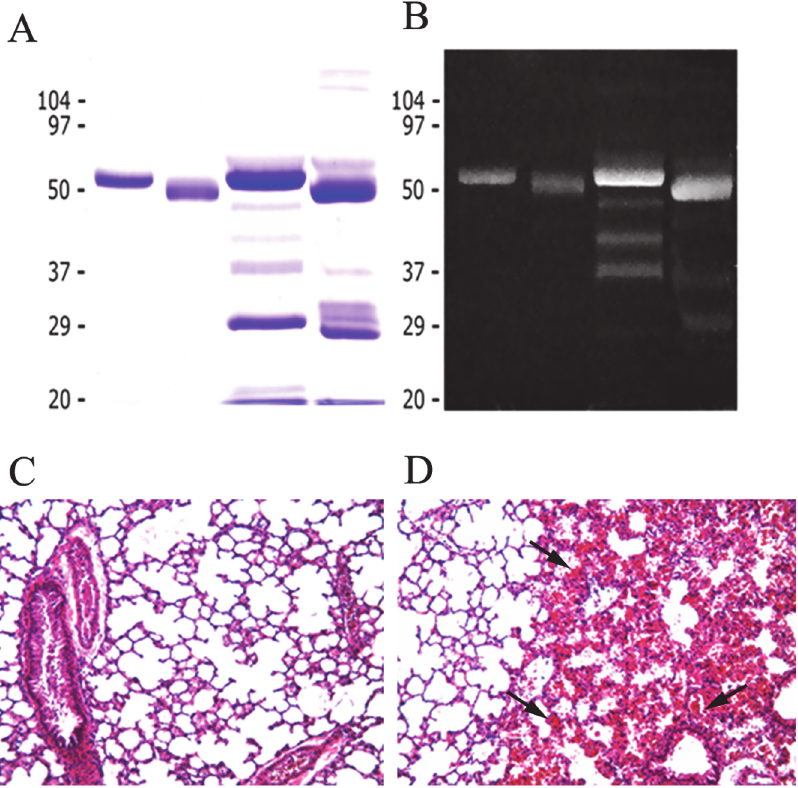
Fig 1. (A), (B) SDS-PAGE of Crotalus simus PIII SVMP and crude venom. Samples were run on a 12% gel, and stained with (A) Coomassie blue or (B) Pro-Q Emerald 300 glycoprotein stain (Molecular